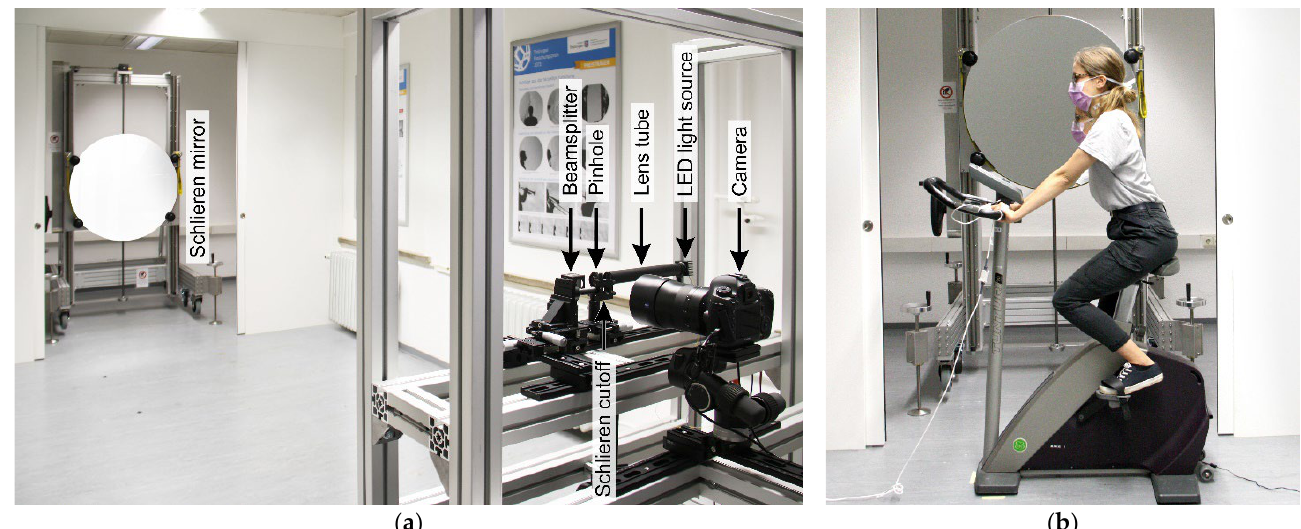
Figure 2. ( a ) The setup of the single-mirror coincident schlieren imaging system; ( b ) A test subject training on the cycle ergometer in front of the schlieren mirror.